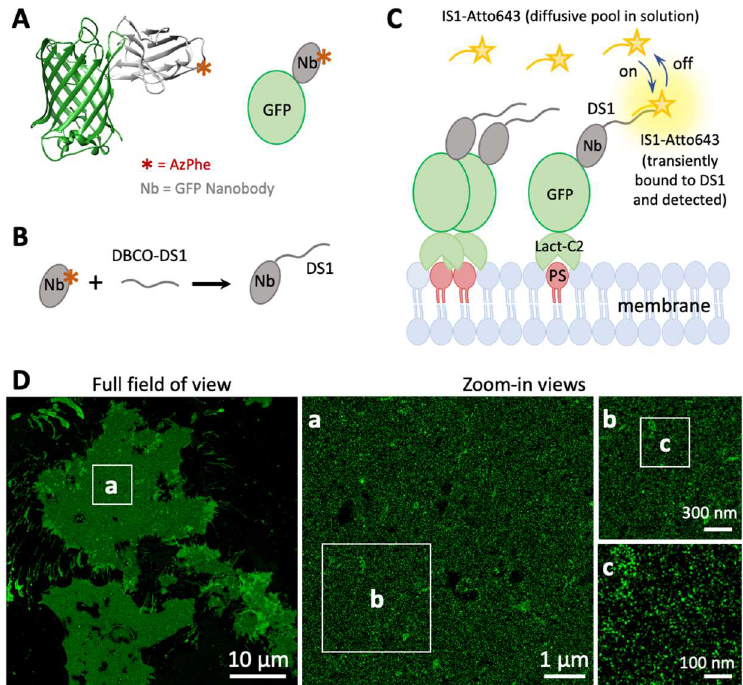
Figure 1. Super resolution imaging of plasma membrane PS in U2OS cells using a combination of the Lact-C2-GFP sensor with DNA-PAINT. ( A ) Structure of the GFP-enhancer nanobody (GFP-Nb) complex (based on PDB ID 3K1K). The location of the artificial amino acid (AzPhe) is indicated by a red asterisk. ( B ) Schematic for the conjugation of the GFP-Nb with a single-stranded DNA oligonucleotide via site-specific click chemistry between AzPhe and dibenzocyclooctyne (DBCO); shown here is the reaction with DBCO-modified docking strand 1 (DS1). ( C ) Schematic of DNA-PAINT imaging showing complementary imager strands (IS1) diffusing above the sample. Binding of IS1 (originally in solution) to DS1 (immobilized on target) and subsequent unbinding generate transient (~0.1 s) single-molecule signals, which accumulate over time to probe all DS1 on the sample. ( D ) Example super resolution image of PS in U2OS cells from the DNA-PAINT process depicted in ( C ). Lact-C2-GFP was transiently expressed in U2OS cells and labeled with the Nb-DS1 prior to imaging. The imaging was performed under total internal reflection to limit the detection volume to the ventral membrane. The image on the left is an overview, with serial magnifications shown in ( a – c ).